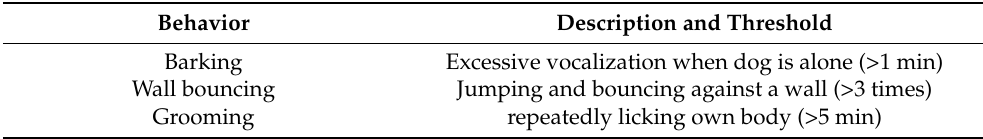
Table 2. Description of potentially abnormal behaviors and their